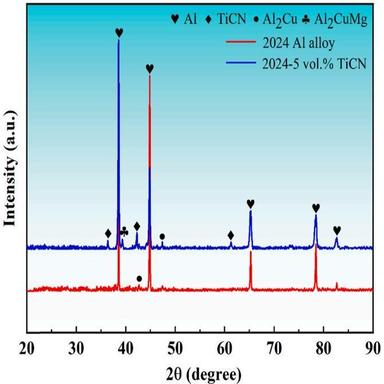
XRD patterns of the as-built samples.